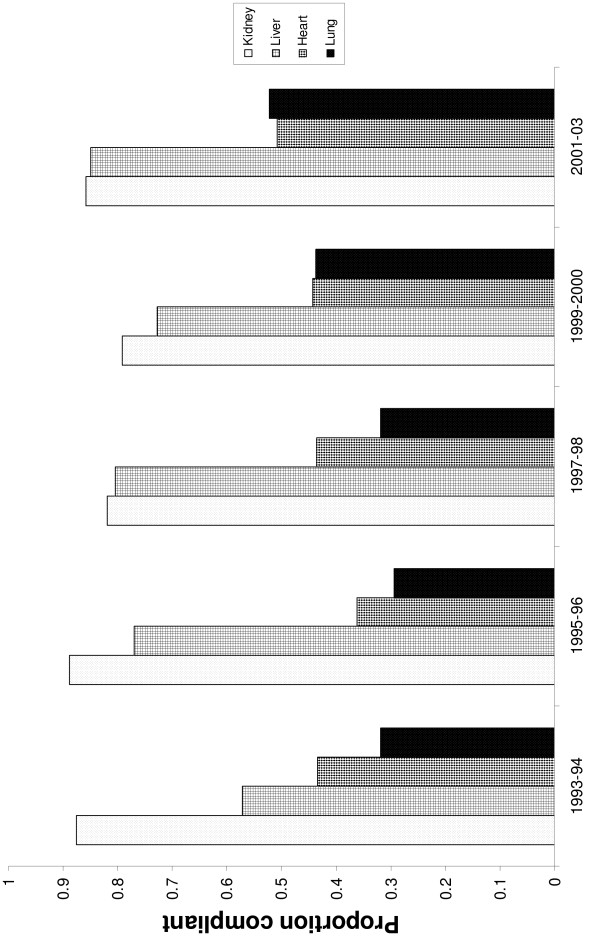
Transplant center compliance with Medicare's volume criteria stratified by year.